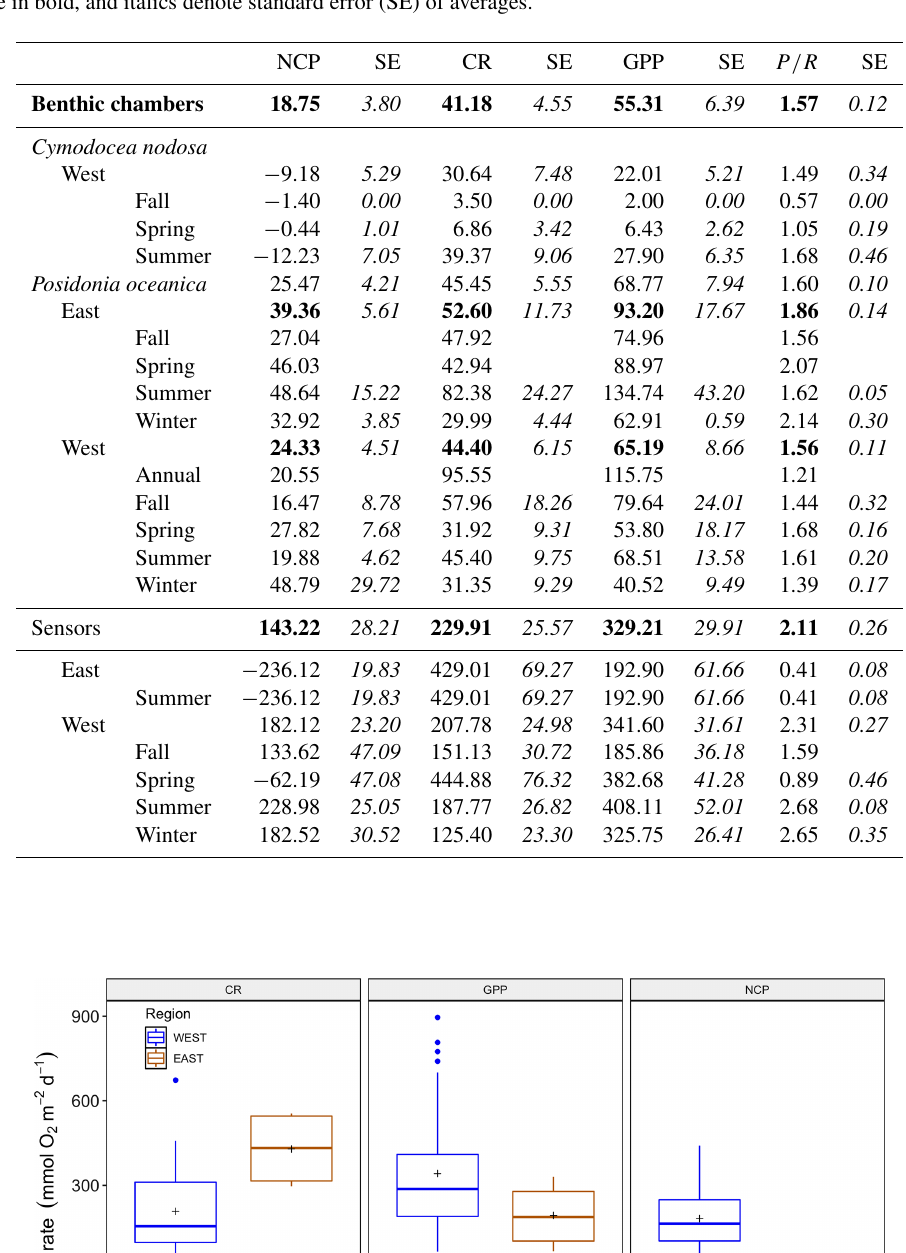
Table 3. Summary of metabolic rates (mmolO 2 m − 2 d − 1 ), for the different methodologies, per region; season; and when, possible, species. Group averages are in bold, and italics denote standard error (SE) of averages.